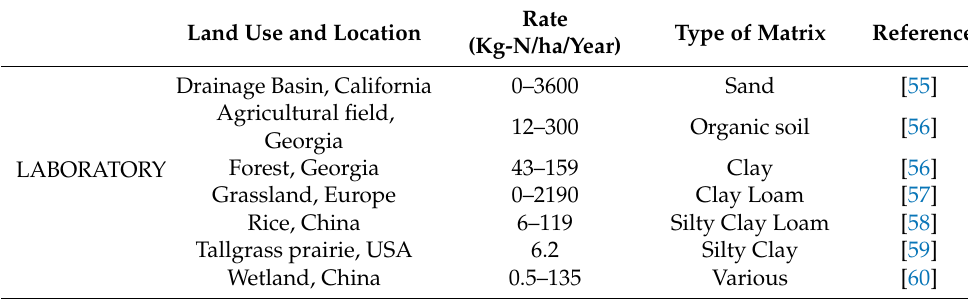
Table 1. DNT rates for different experimental setup, land use, and